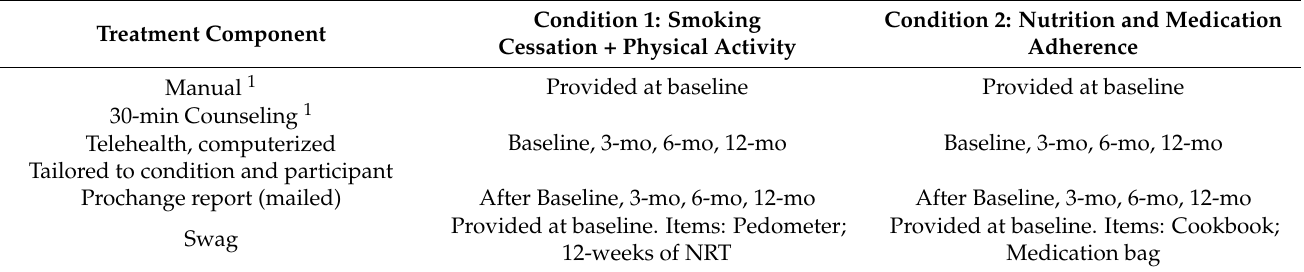
Table 1. Comparison of intervention